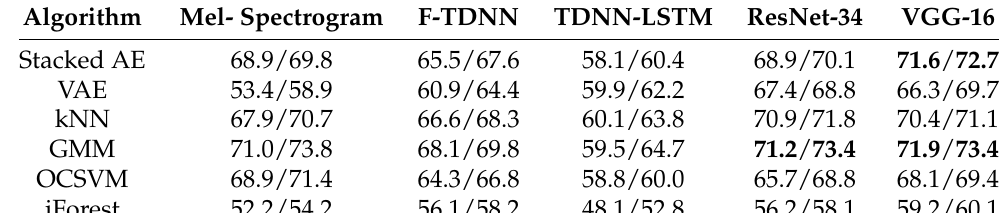
Table 4. The Average F1/AUC Scores of AND on ESC-50 dataset.